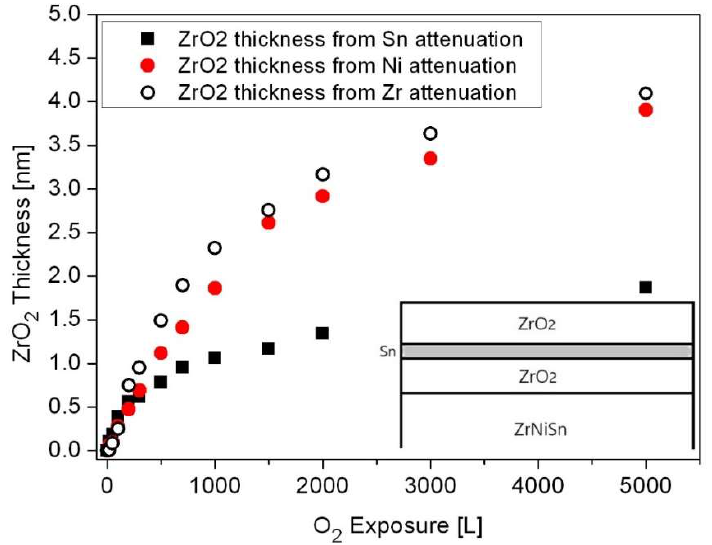
Figure 12. Oxide thickness formed during exposure to O 2 at 1000 K, as calculated from the attenuation of the Sn, Ni and Zr peaks. The inset describes a schematic view of the oxide morphology.